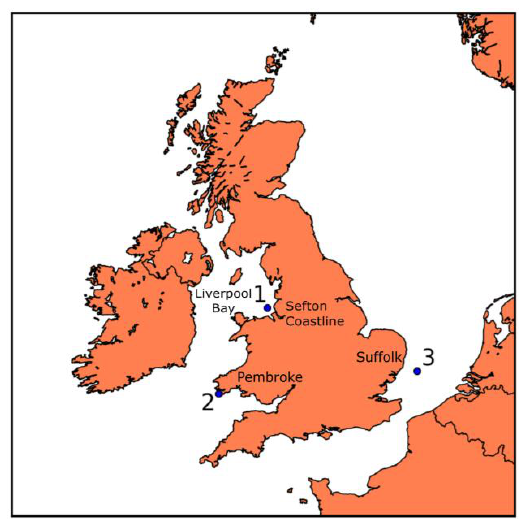
Figure 2. WaveNet buoy locations: ( 1 ) Liverpool Bay; ( 2 ) Pembroke; ( 3 ) West Gabbard.